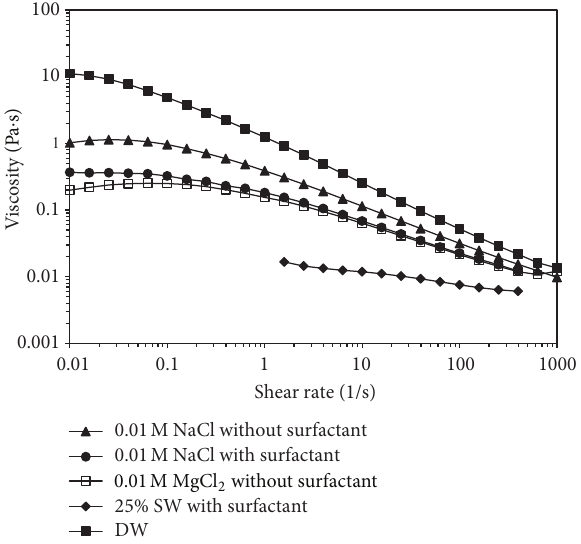
Figure 19: Effect of different salt on steady shear viscosity of copolymer at 50 ∘